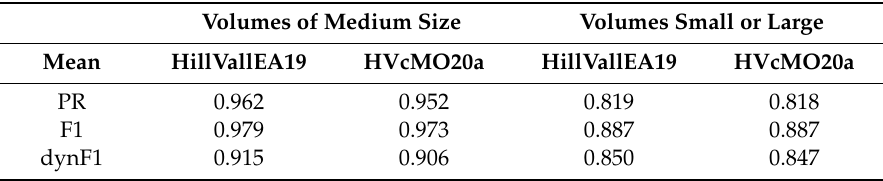
Table 11. Scores averaged at all accuracy levels on problems grouped by the search space